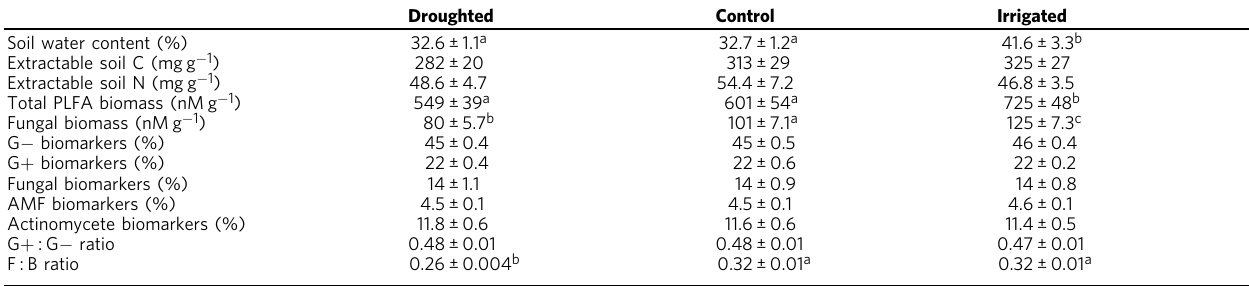
Table 1 Soil properties and microbial biomarker groups in soils from chronic climate change treatments.